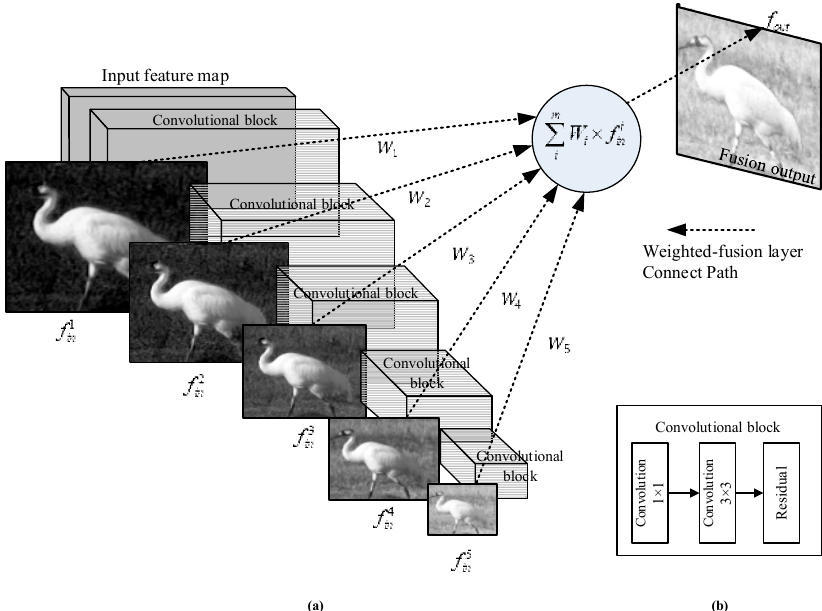
Figure 3. Illustration of learnable fusion architecture. ( a ) The main framework of learnable fusion. ( b ) Convolutional block.